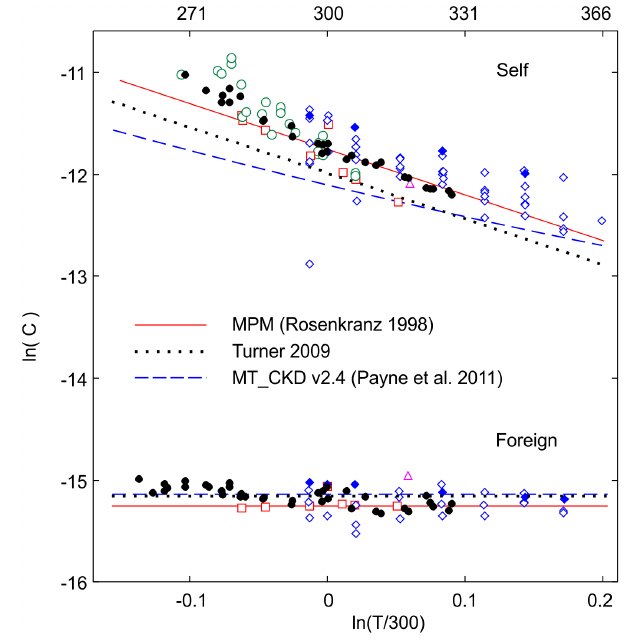
Figure 3. Self-broadened (pure water vapor or quadratic with hu- midity) and foreign-broadened (mixture with air or linear with hu- midity) continuum coefficients C (in (dBkm − 1 )/(GHzkPa) 2 ) , as in Rosenkranz (1998, 1999). Symbols are field and laboratory data (filled blue diamonds are from Kuhn et al., 2002; open blue dia- monds are from Godon et al., 1992 and Bauer et al., 1993, 1995; green open circles are from Katkov et al., 1995; red squares are from Liebe, 1984 and Liebe and Layton, 1987; black dots are from Koshelev et al., 2011; pink triangles are from Becker and Autler, 1946). Statistical uncertainty of individual points in each series is approximately equal to or less than the size of the points. Solid lines are continuum coefficients derived by Rosenkranz (1998) for the Millimeter-wave Propagation Model (MPM). Dotted and dashed blue lines correspond to scaling of these coefficients on the basis of radiometric data suggested by Turner et al. (2009) and Payne et al.